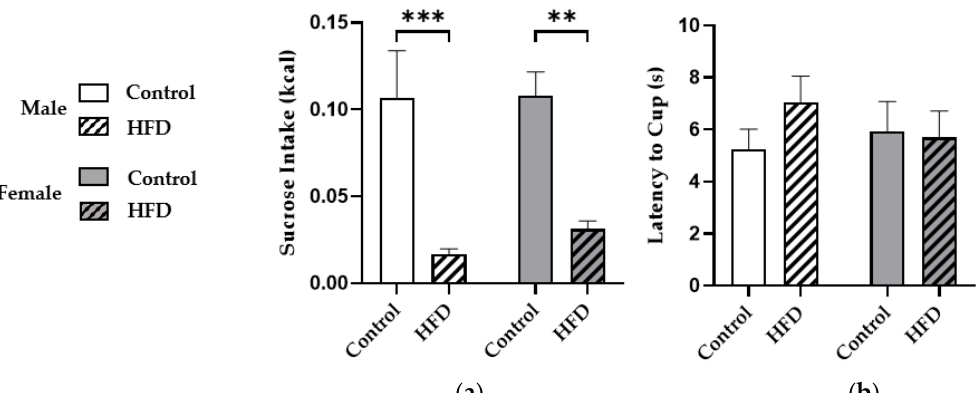
Figure 2. Sucrose Consumption and Latency to Approach Sucrose during the Novelty-Induced Hypophagia (NIH) Test. Sucrose intake in kcals ( a ) and latency to approach the sucrose cup in seconds ( b ) during the NIH test. * denotes a significant difference between diet groups. **, p < 0.01; ***, p < 0.001.